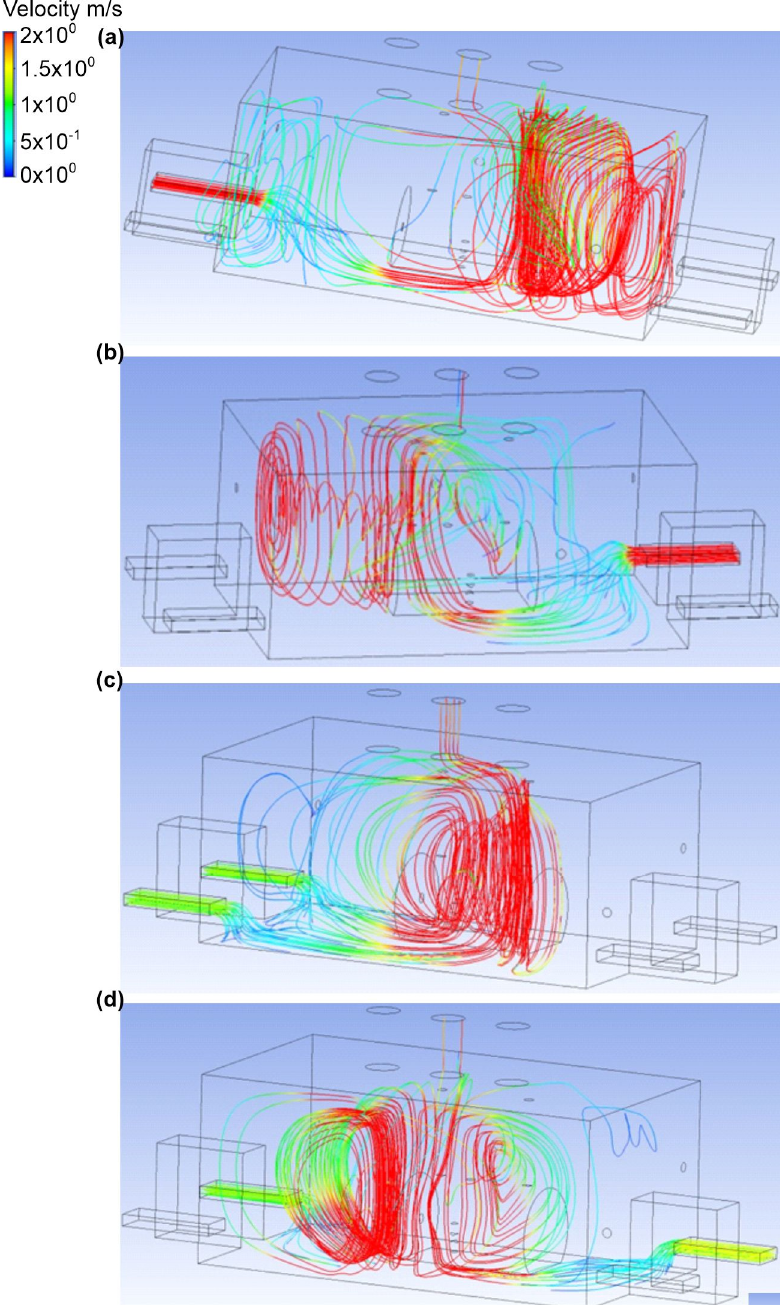
Figure 5. Velocity distribution in the engine room for: ( a ) scenario A, ( b ) scenario B, ( c ) scenario C, and ( d ) scenario D.